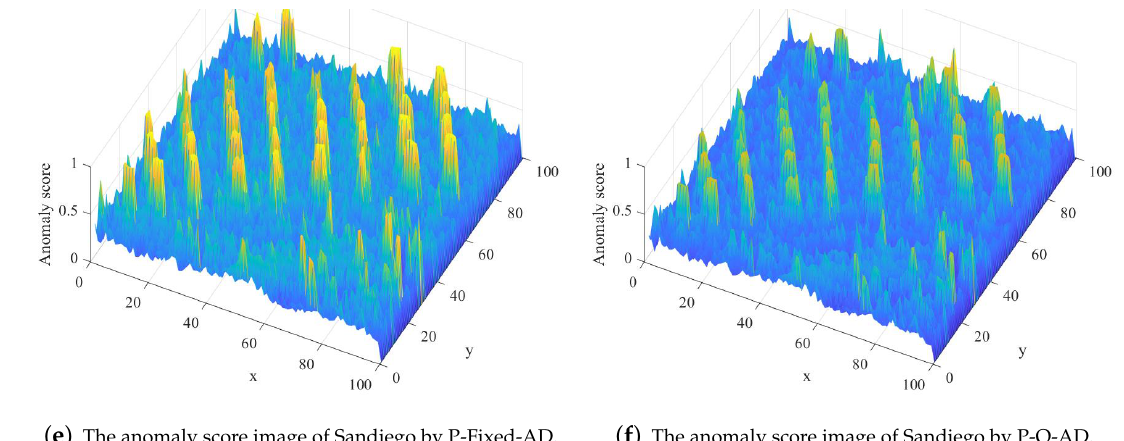
( c ) The anomaly score image of Sandiego by Floating-AD. ( d ) The anomaly score image of Sandiego by P-Floating-AD.